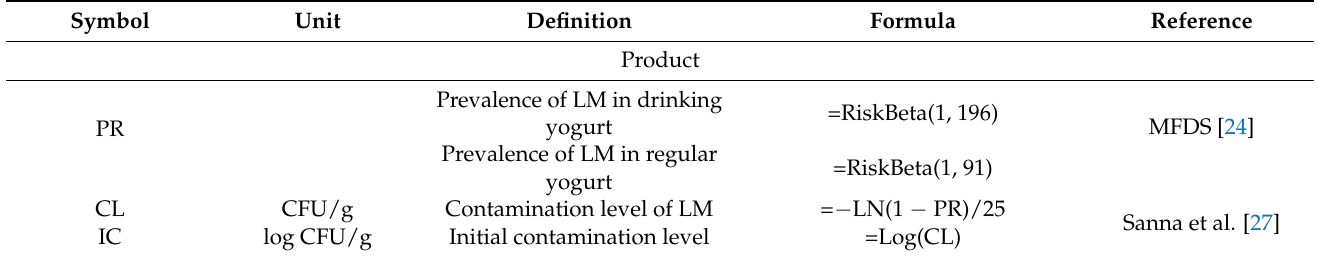
Table 2. Simulation model and formulas in the Excel spreadsheet used to calculate the risk of Listeria monocytogenes (LM) in drinking and regular yogurt with